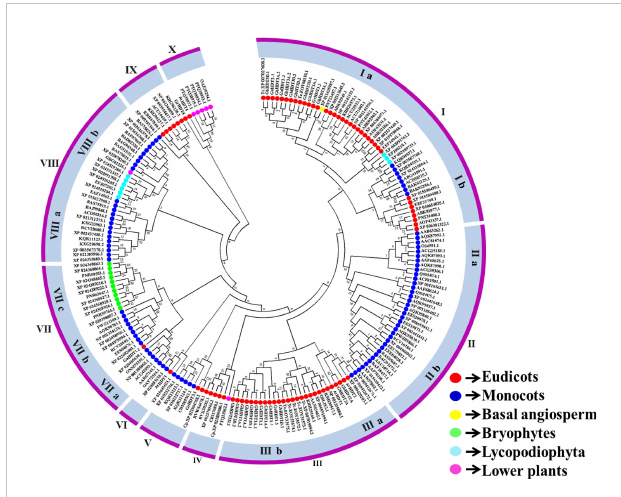
FIGURE 4 Phylogenetic relationships of cotton HD2s with other plant species and Arabidopsis thaliana